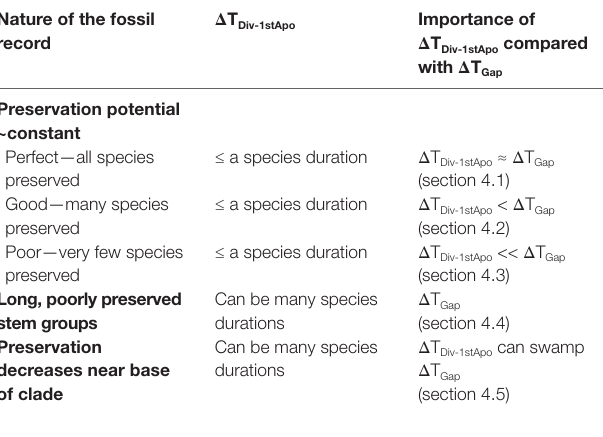
TABLE 4 | Relative magnitudes of ΔT Div-1stApo (the difference between the paleontological estimate of the true time of origin of the first fossilizable apomorphy and the paleontologically unobservable lineage divergence time) and ΔT Gap [the size of the gap between the first appearance in the fossil record ( FAD ) and the true time of origin of that first fossilizable apomorphy] (see Figure 1A ). Nature of the fossil ΔT record